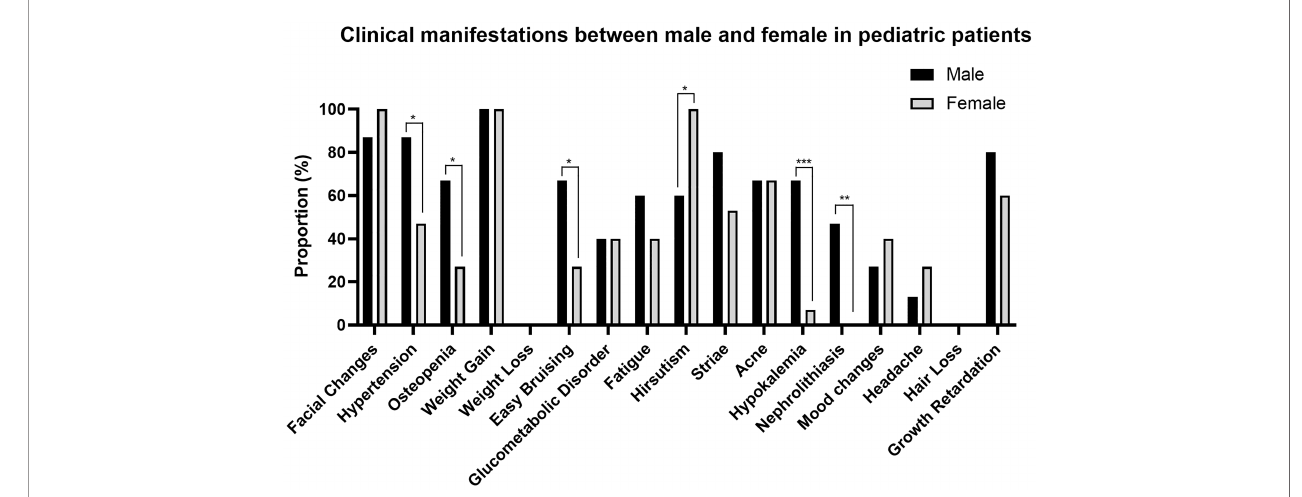
FIGURE 2 | Clinical manifestations between males and females in pediatric patients. * P < 0.05, ** P < 0.01, *** P < 0.001.